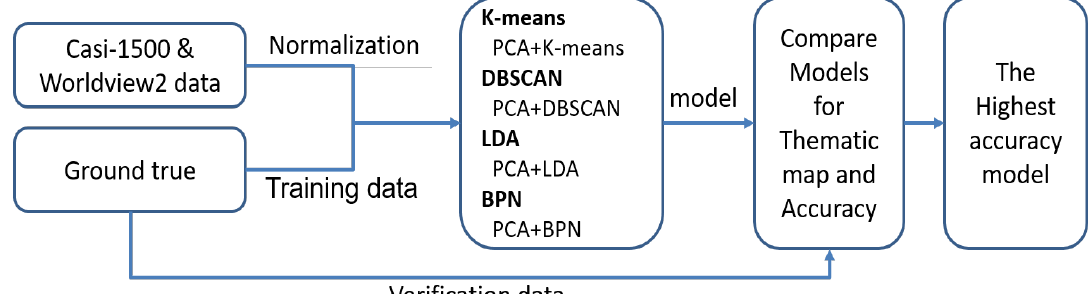
Figure 4. Research Steps. This study used multispectral images (WorldView-2) and hyperspectral images (CASI-1500) and focused on the classifiers K-means, density-based spatial clustering of applications with noise (DBSCAN), linear discriminant analysis (LDA), and back-propagation neural network (BPN). Then the feature selection (principle component analysis, PCA) on four classifiers is studied.